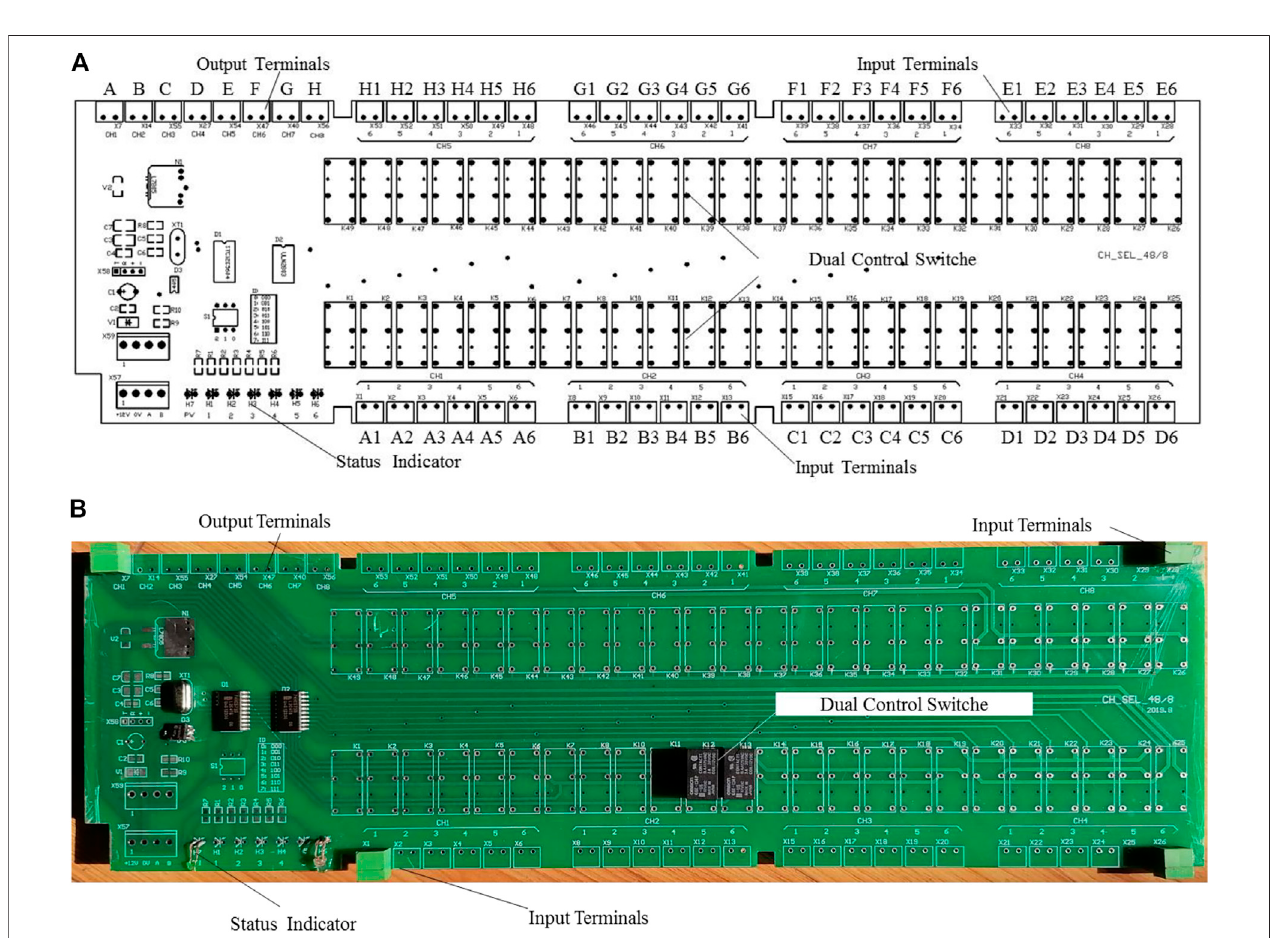
FIGURE 4 | Circuit diagram and circuit board of multi-channel selection module.